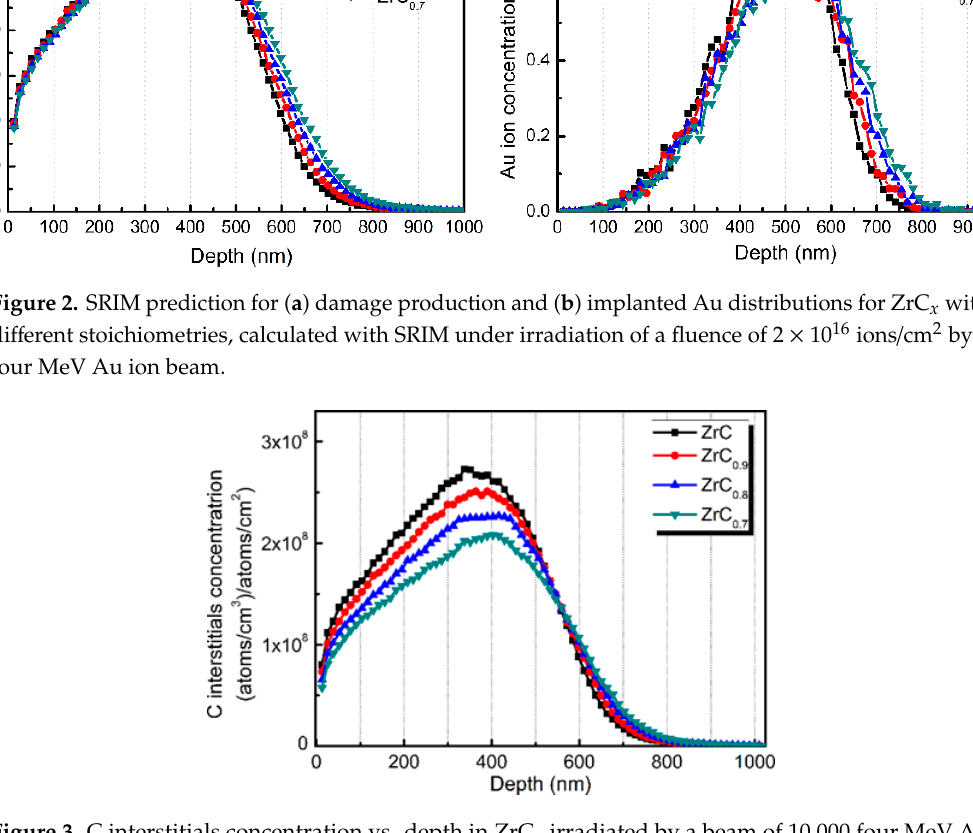
Figure 3. C interstitials concentration vs. depth in ZrC x irradiated by a beam of 10,000 four MeV Au ions calculated with SRIM.